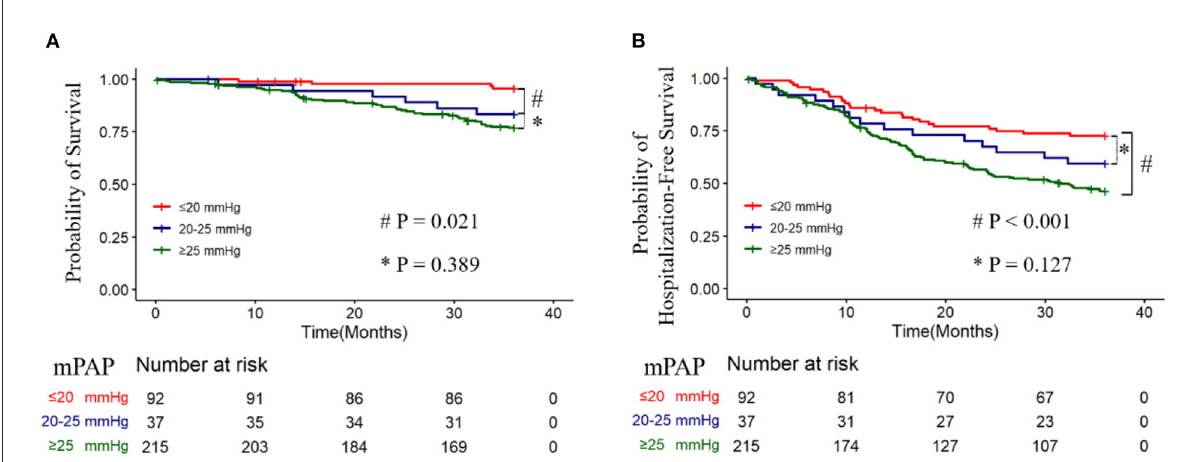
FIGURE2 3-year survival and hospitalization-free survival for without pulmonary hypertension (PH) (mPAP ≤ 20 mmHg), borderline PH (21–24 mmHg), and traditionally defined PH ( ≥ 25 mmHg) patients, and Kaplan-Meier analysis of the probability of all-cause mortality (A) (Log-rank, p < 0.001) and rehospitalization (B) (Log-rank, p < 0.001) was